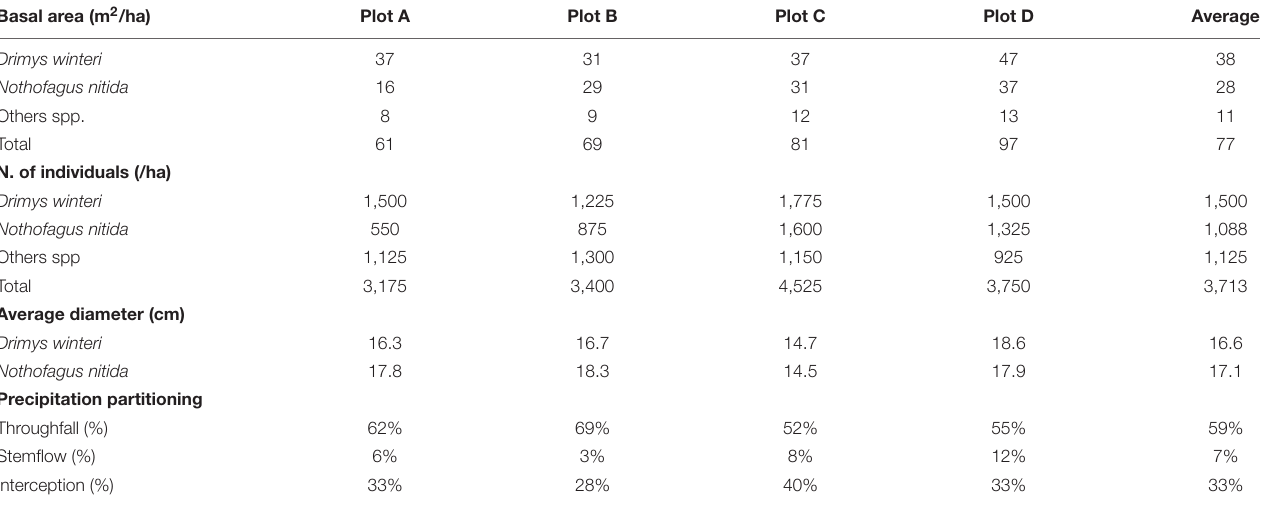
TABLE 1 | Forest attributes per plot in second-growth forests of Chiloé. Basal area (m 2 /ha) Plot A Plot B Plot C Plot D Average Drimys winteri 37